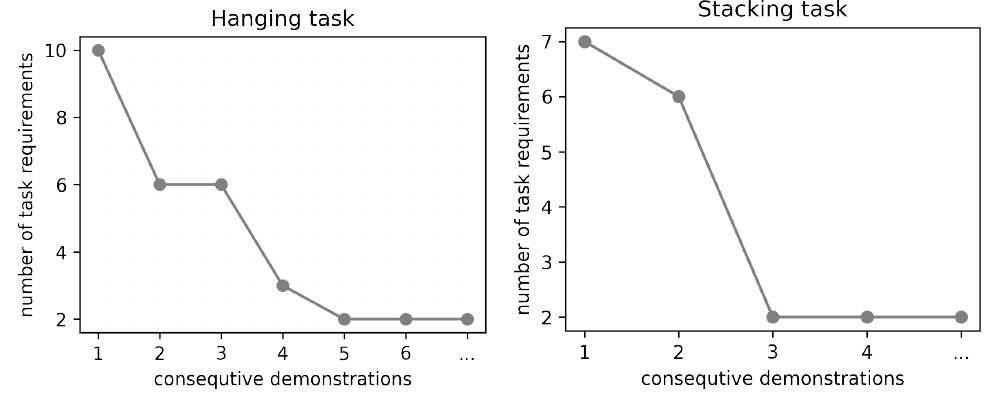
Figure 8. Plots of the learning process in the task of hanging ( left ), and stacking ( right ). The number of inferred task requirements decreases with each demonstration to then converge to a